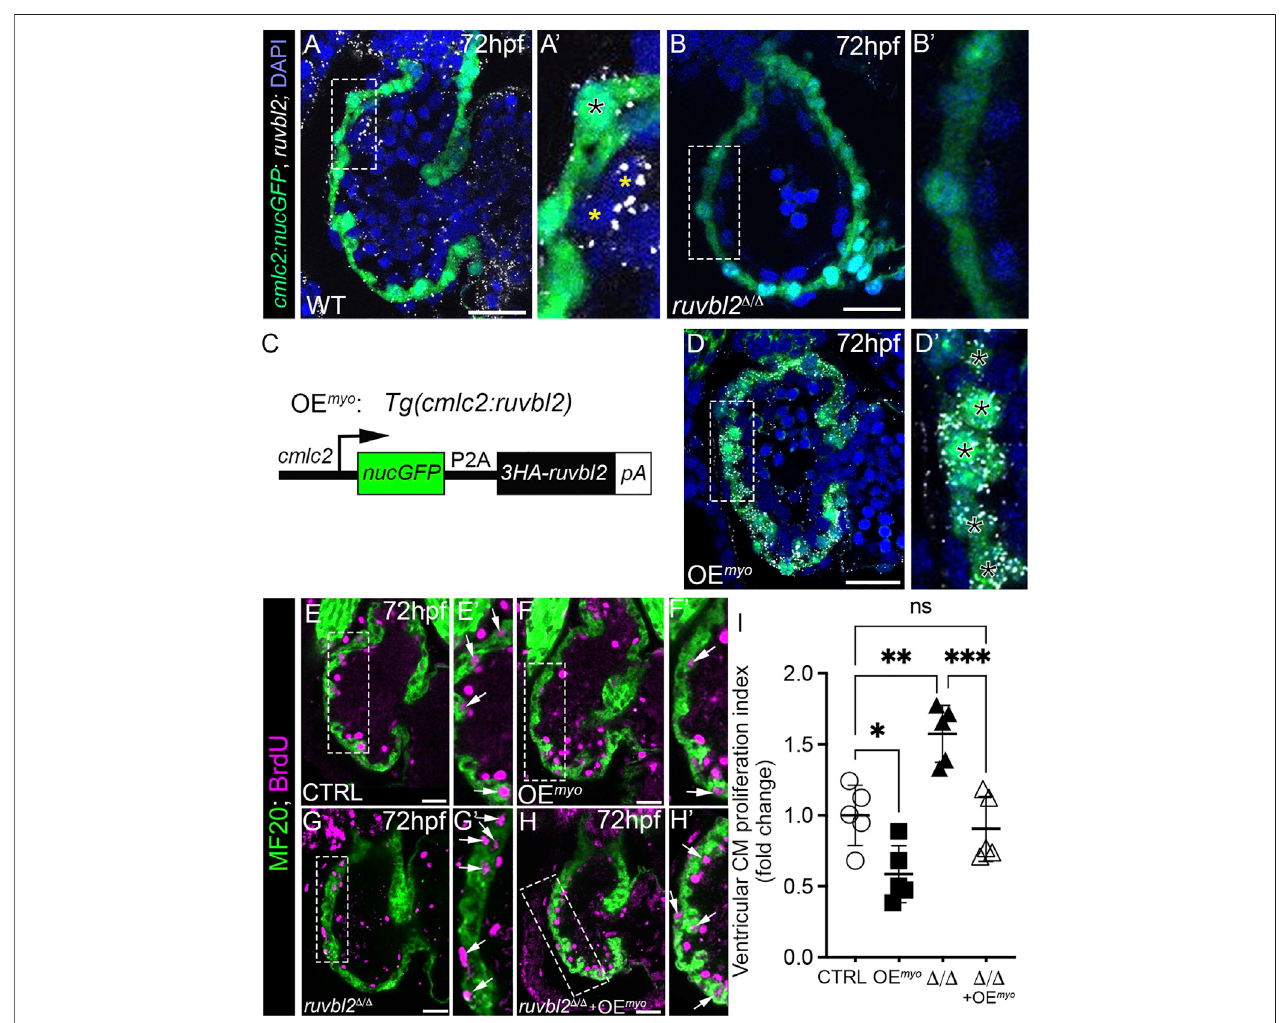
FIGURE 3 | Myocardial expression of Ruvbl2 rescues cardiomyocyte hyperproliferation in ruvbl2 Δ / Δ mutants. (A – B 9 ) Confocal single plane optical sections of endogenous ruvbl2 expression (white signal) relative to myocardium (green signal) processed by RNAscope fl uorescent in situ hybridization and immunohistochemistry for GFP in wild-type (A, A ′ ; n = 4) or ruvbl2 Δ / Δ (B, B ′ ; n = 4) Tg ( cmlc2:nucGFP ) embryos with DAPI nuclei counterstaining (blue signal). Boxed regions in A and B are shown at higher magni fi cations in A ′ and B ′ , respectively. The black asterix in A ′ denotes myocardial ruvbl2 expression, while yellow astrices mark presumptive endocardial ruvbl2 expression. (C) Schematic ofthetransgenegeneratedtoachieve constitutive ruvbl2 overexpressioninthemyocardium (OEmyo). (D) Confocalsingle plane optical section of the ruvbl2 expression domain (white signal) relative to myocardium (green signal) processed by RNAscope fl uorescent in situ hybridization and immunohistochemistryforGFPin Tg ( cmlc2:ruvbl2 ) Tg ( cmlc2:nucGFP )doubletransgenicembryos( n =4)withDAPInucleicounterstaining(bluesignal).Boxedregionin D is shown at higher magni fi cations in D ′ . Black asterices in (D 9 ) denote myocardial ruvbl2 expression, which when compared to wildtype (A,A 9 ) is substantially higher. (E – H 9 ) Single plane confocal images of wildtype control (E,E 9 ) , OEmyo (F,F 9 ) , ruvbl2 Δ / Δ (G,G 9 ) , ruvbl2 Δ / Δ with OEmyo (H,H 9 ) hearts double immunostained to detect cycling(BrdU+)cardiomyocytes(MF20+)at72 hpf.Boxedregionsin (E – H) aremagni fi edin (E 9 – H 9 ) withwhitearrowshighlightingdoublepositivecells.Samplesizesare n = 6 for all groups. (I) Quanti fi cation of fold change in cardiomyocyte proliferation indices between cohorts. Means ± s.d are shown. ns; not signi fi cant; * p < 0.05, ** p < 0.01, *** p < 0.001. Scale bars: 25 μ